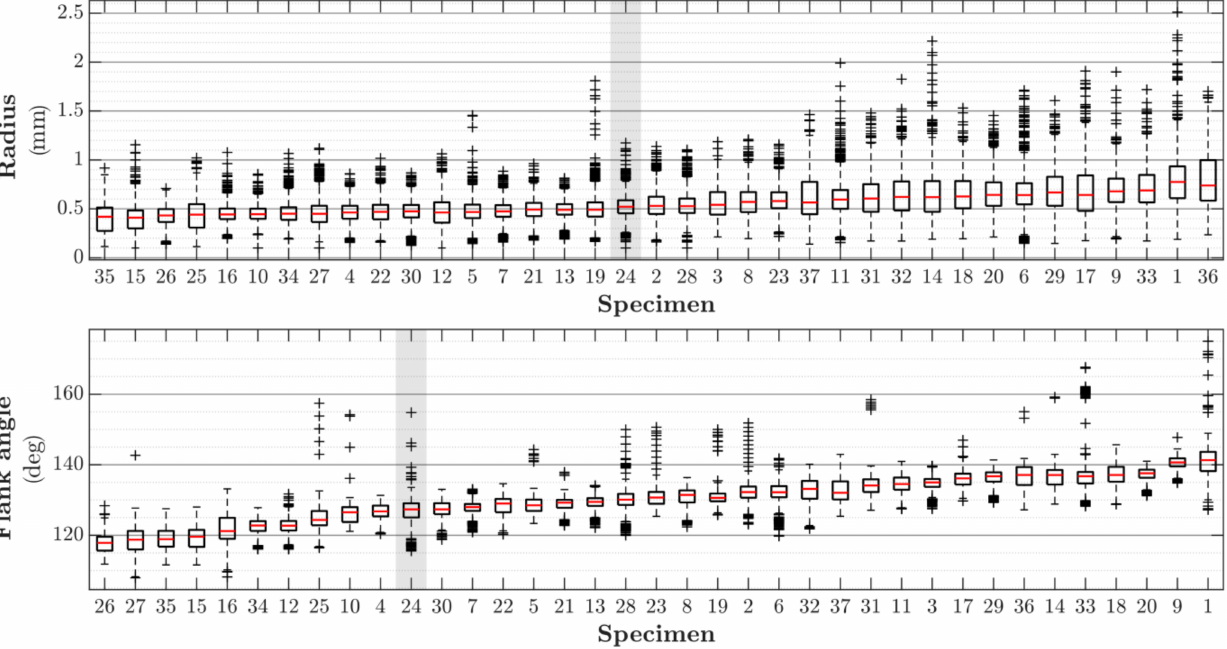
Figure 5. Variation of geometry within the tested group of specimens.